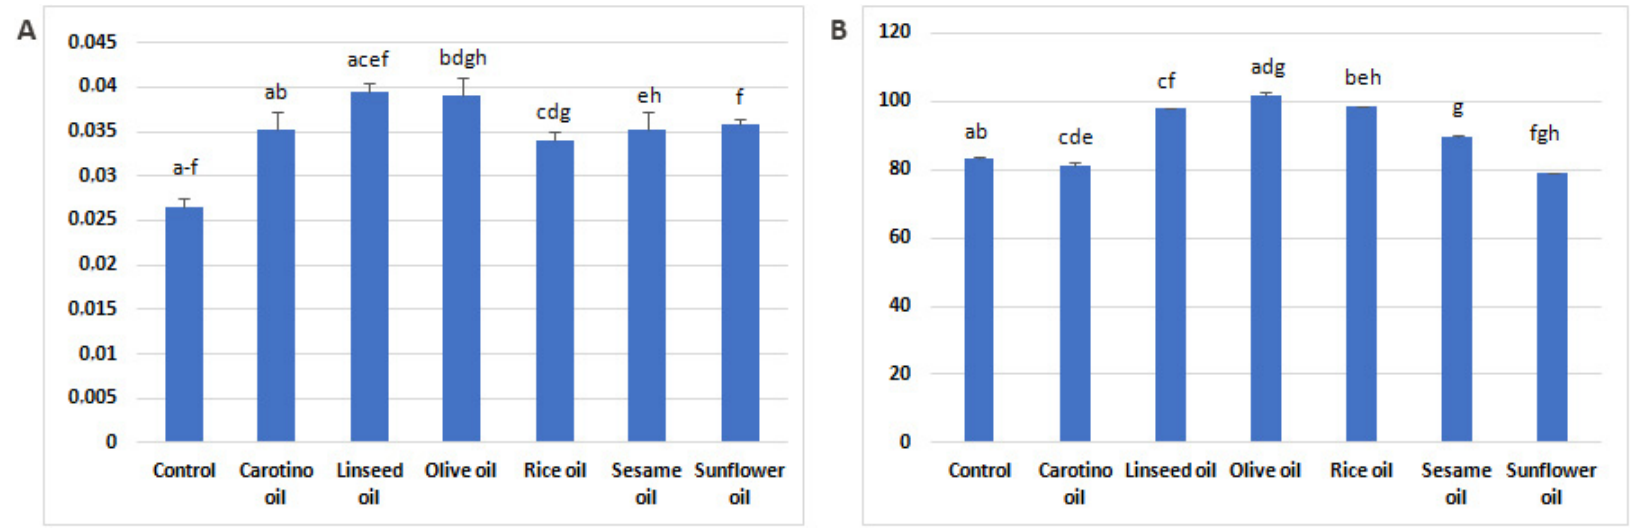
Figure 2. Activities of D6D ( A ) and D5D ( B ) in rat serum. All data are shown as mean values ± standard deviation. Bars with the same superscript (a–h) above are significantly different in one-way ANOVA followed by RIR Tukey’s post-hoc test (D6D) or Kruskal–Wallis test followed by multiple comparison test (D5D) ( p ≤ 0.05). D6D— Δ 6-desaturase index, D5D— Δ 5-desaturase index. Table 4. Contents of arachidonic, linoleic, and eicosapentaenoic acid metabolites in serum of rats supplemented with diverse edible oils (ng/mL serum)